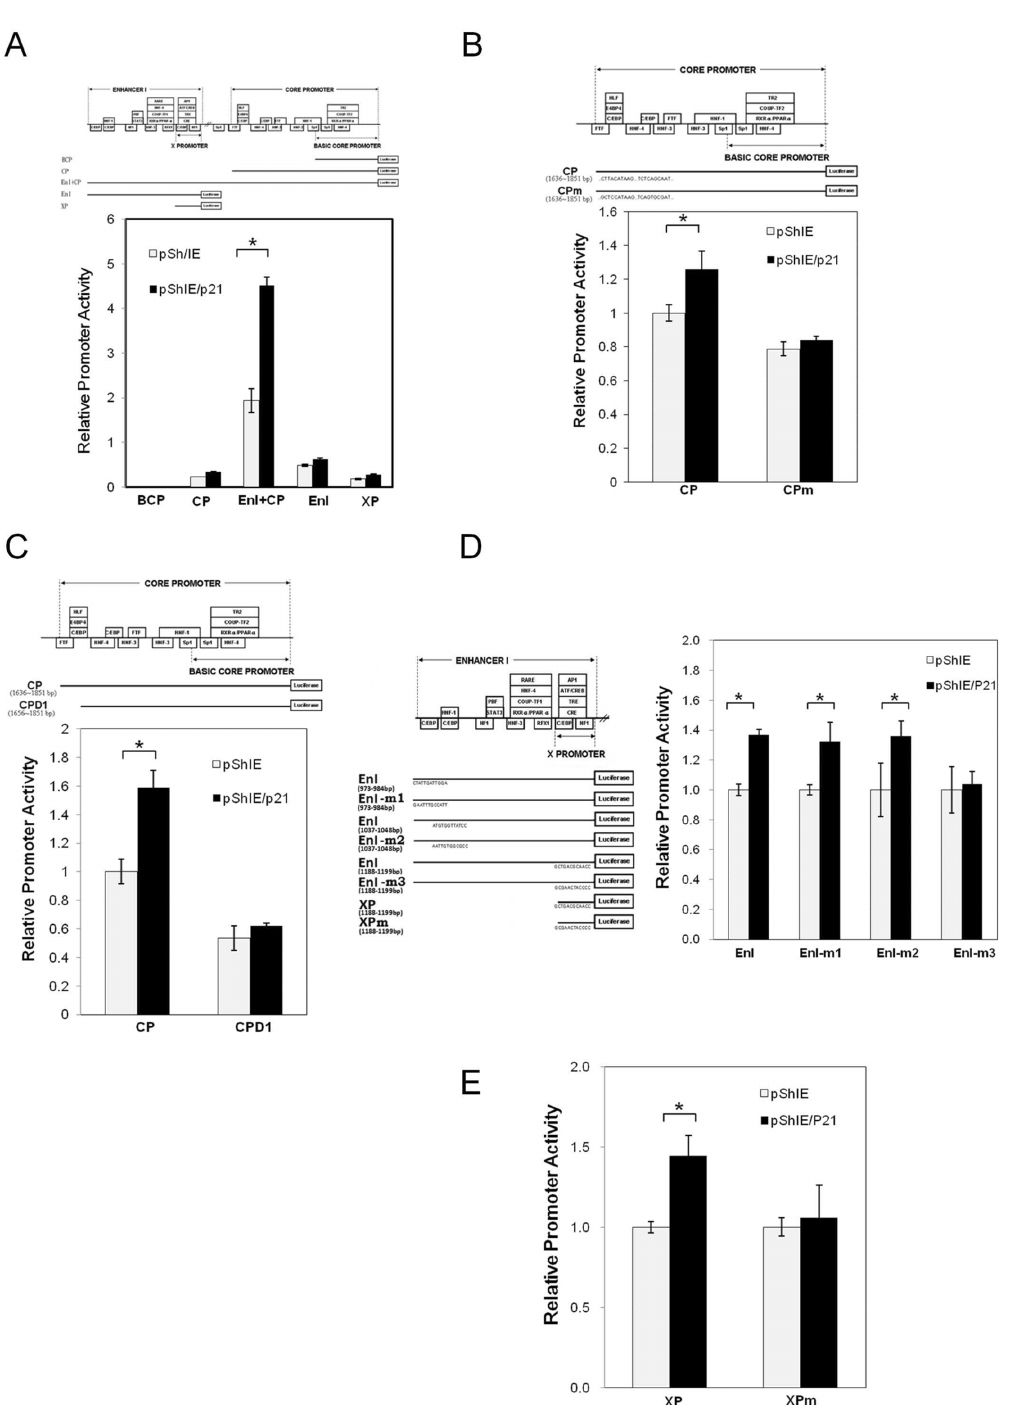
Fig 3. Identification of p21 responsive elements within the HBV genome. HepG2 cells were co-transfected with pShIE/p21 or mock control (pShIE) together with an appropriate indicated luciferase reporter plasmid. These were (A) luciferase reporter plasmids driven by the various HBV promoters, namely the BCP (basic core promoter), the CP (core promoter), EnI+CP (enhancer I plus the core promoter), EnI (enhancer I) and XP (the X promoter), (B) luciferase reporter plasmid driven by the HBV core promoter (CP) and the HBV core promoter with a deletion (CPD1), or the HBV core promoter with a mutation at two C/EBP binding sites (CPm), (D) luciferase reporter plasmid driven by the HBV EnI and EnI with mutations at three different C/EBP binding sites (EnI-m1, EnI- m2 and EnI-m3). (E) luciferase reporter plasmid driven by the HBV X promoter and HBV X promoter with a mutation at the C/EBP binding sites (XPm). Cells